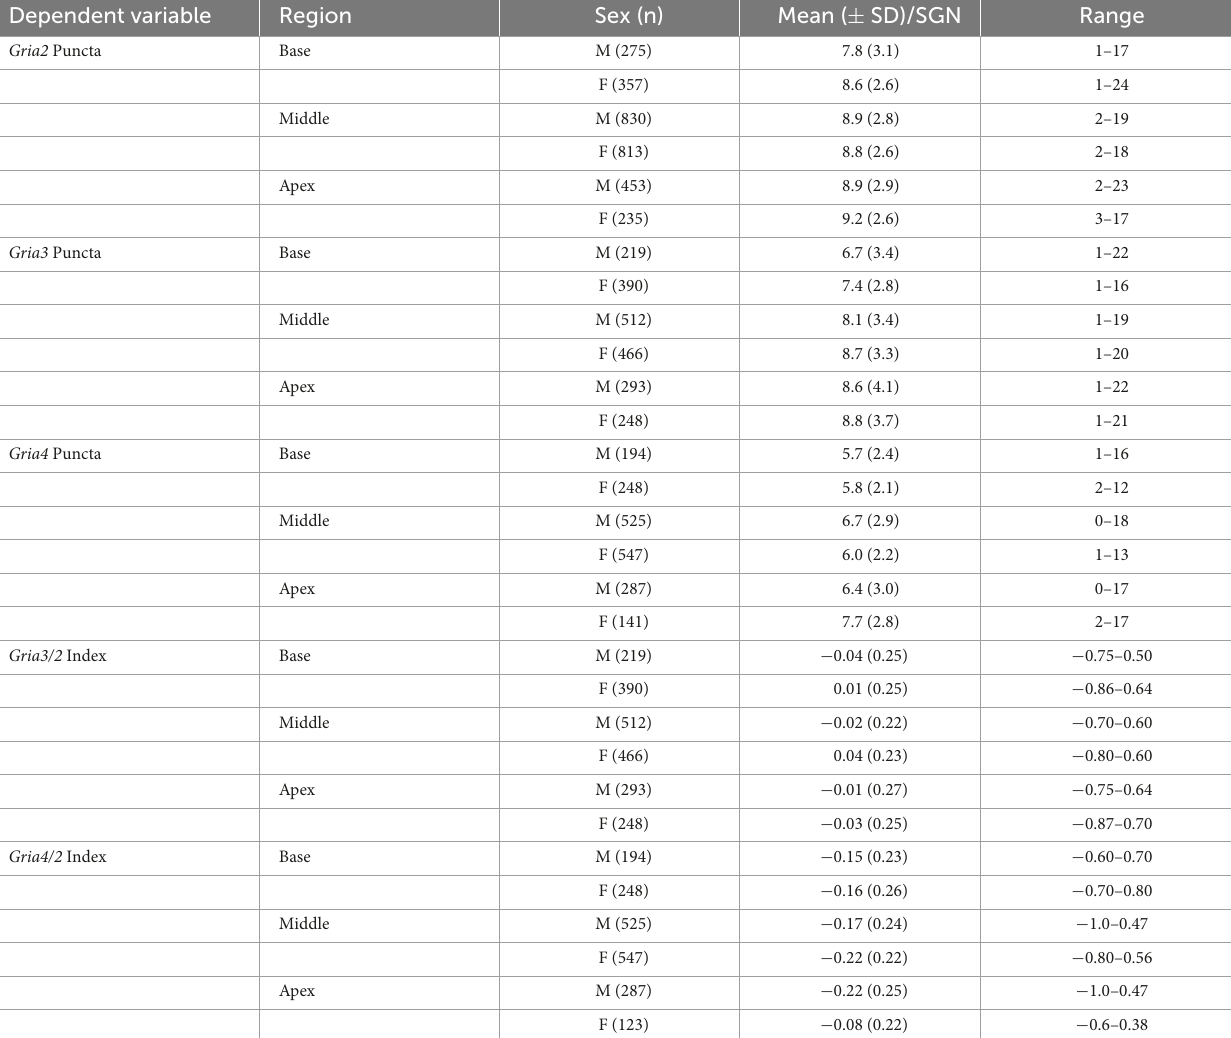
TABLE 2 Summary of AMPAR mRNA descriptive